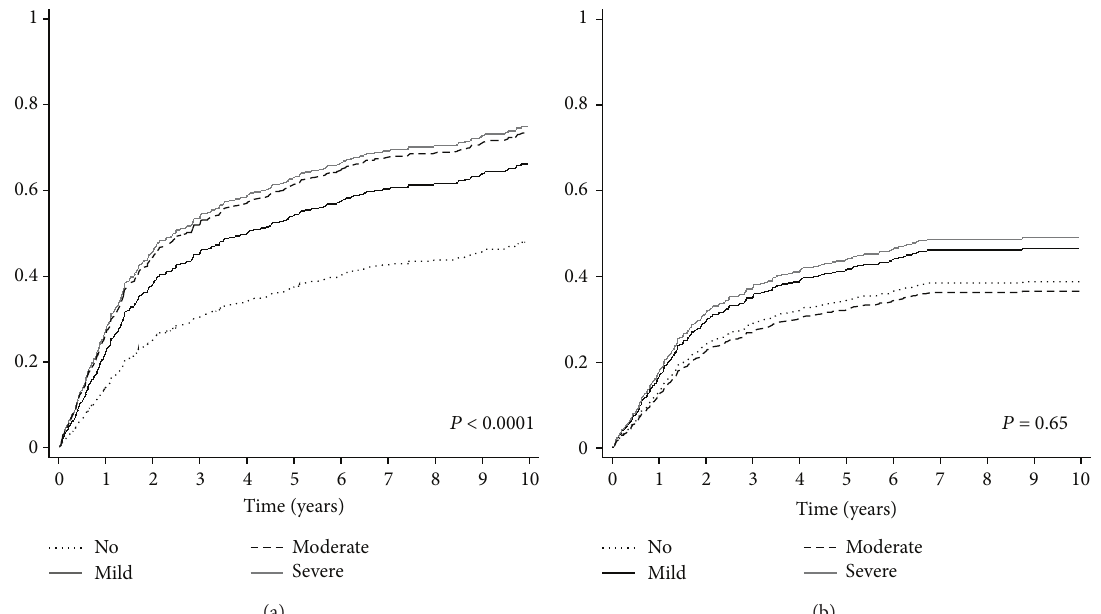
Figure 3: The crude cumulative incidence function of overall (a) and disease-specific mortality (b) by Charlson Comorbidity score.